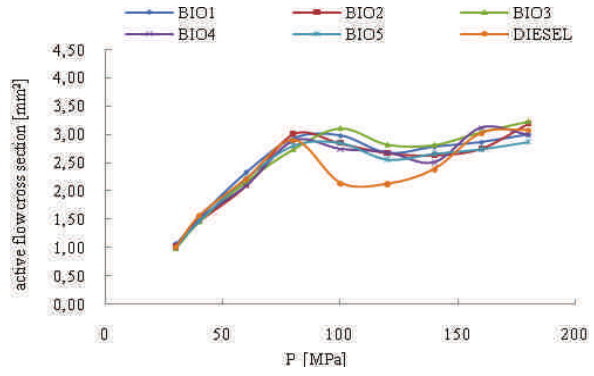
Fig. 2. Comparison of the active flow cross sections of tested fuels at 30°C